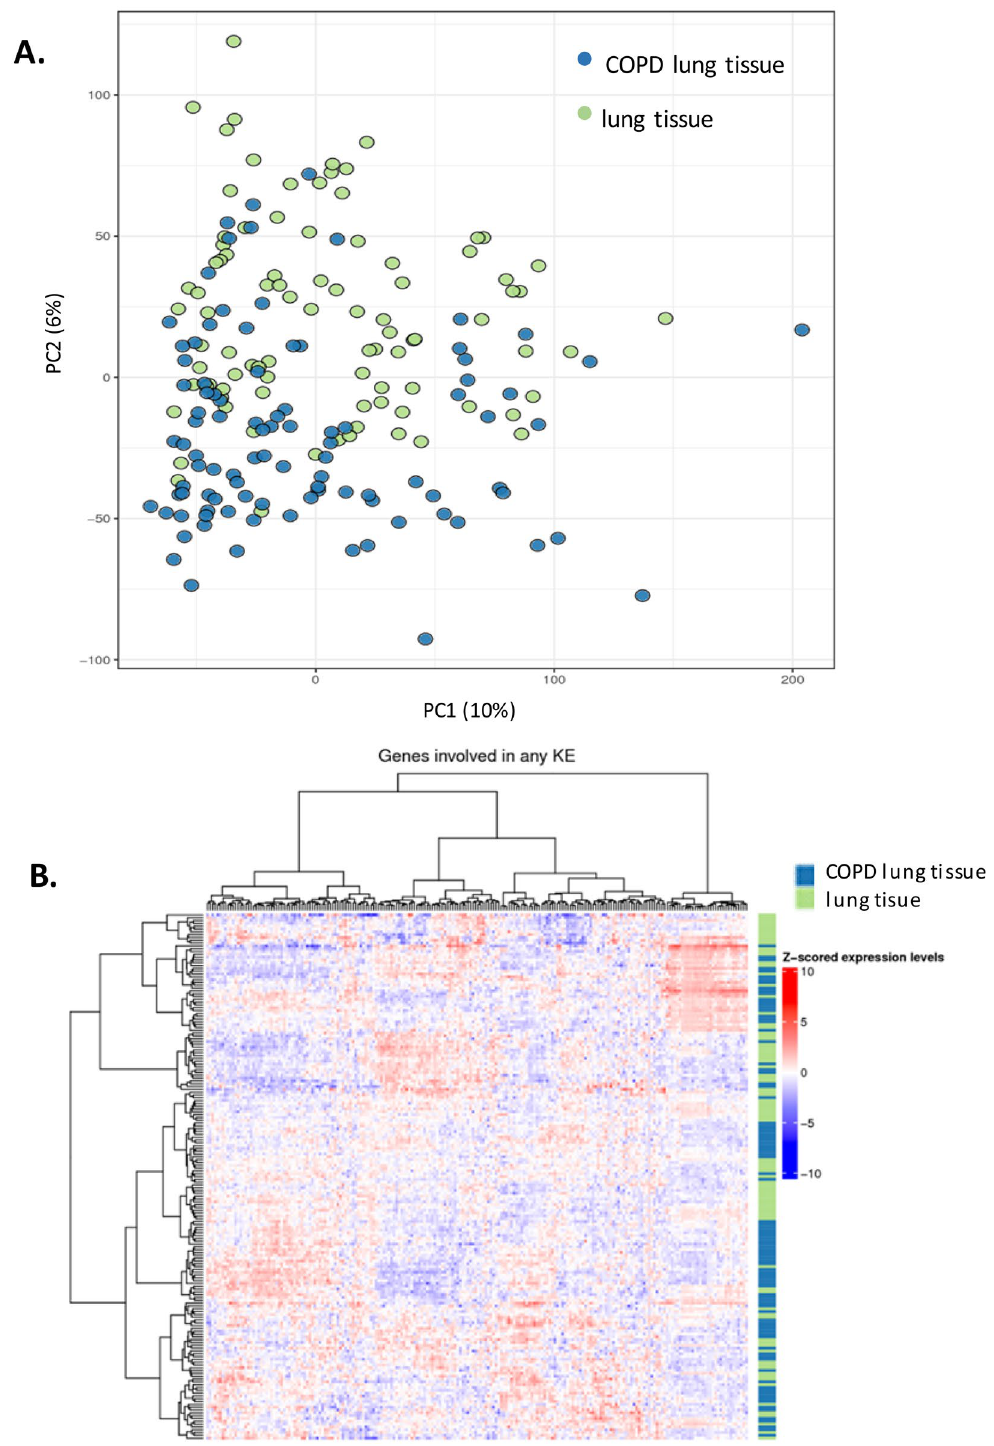
Figure 5. Application of the KE genesets to samples from COPD and non-COPD lung biopsies. ( A ) Principal component analysis comparing the whole normalized RNA-seq data from the COPD and non-COPD samples. ( B ) Unsupervised clustering using the COPD and non-COPD gene expression data and the pooled genesets from the five